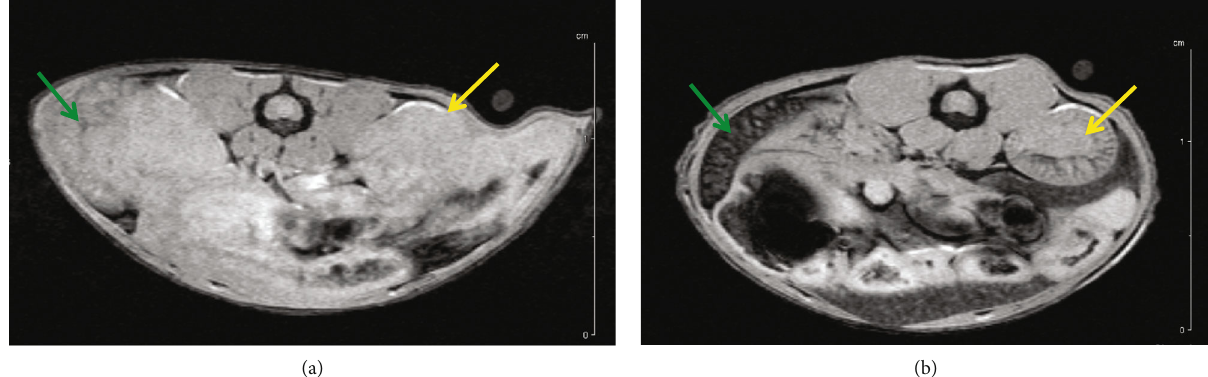
Figure 2: FLASH-kidney-spleen prescan (a); FLASH-kidney-spleen 10 min p.i. (b). Annotation shows the liver (yellow arrows) and the spleen (green arrows).